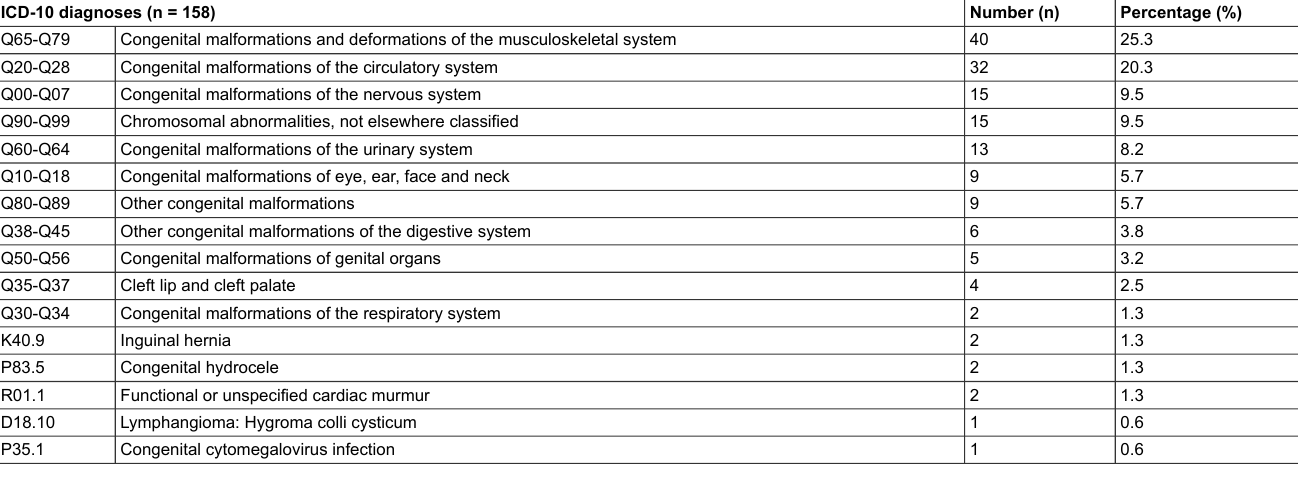
Table 4: ICD-10 categories for malformations observed after exposure to at least one medication during a singleton pregnancy. ICD-10 diagnoses (n =